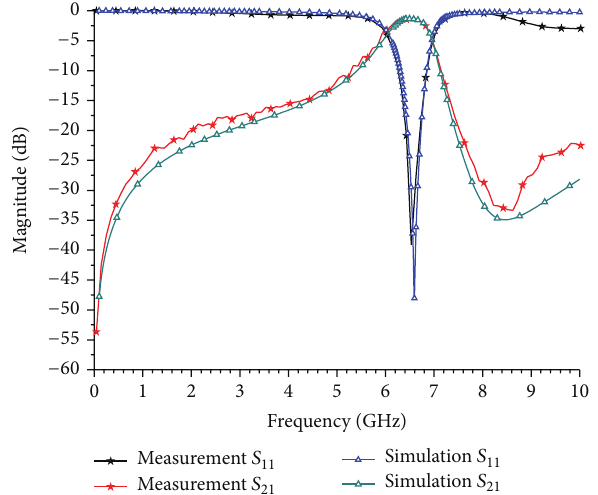
Figure 7: Simulated and measured results of the proposed BPF.